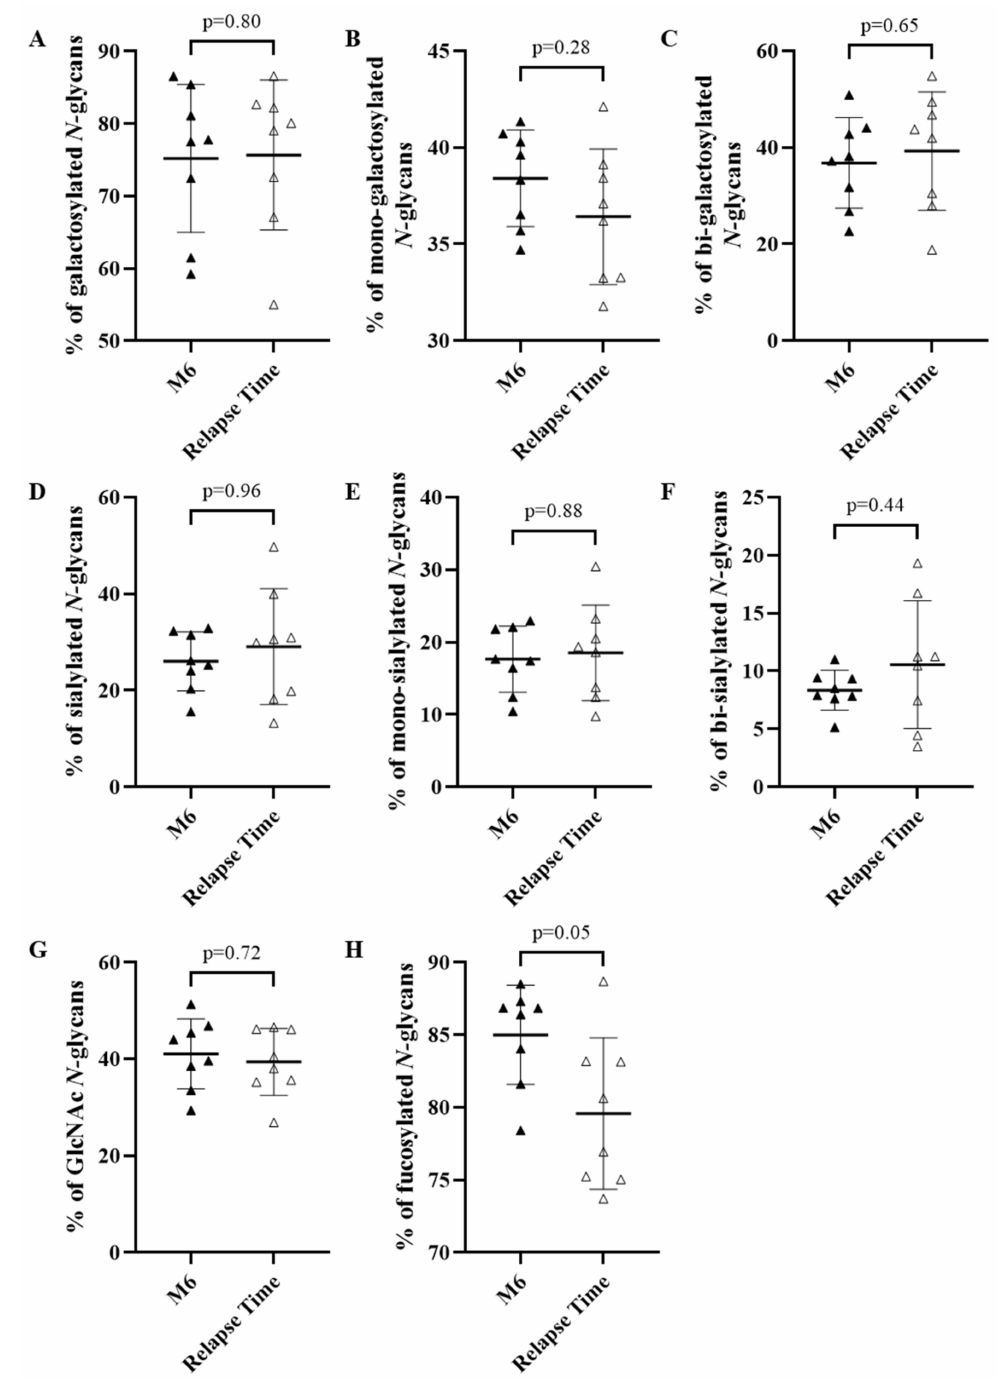
Figure 4. The N- glycome of relapsing patients during relapse occurrence compared to the N- glycome of non-relapsing patients at 6 months (M6). The percentage based on the relative quantification of galactosylated ( A ), mono-galactosylated ( B ), bi-galactosylated ( C ), sialylated ( D ), mono-sialylated ( E ), bi-sialylated ( F ), N- acetylglucosamine (GlcNAc) ( G ), fucosylated ( H ) subgroup of N- glycans from IgG of non-relapsing and relapsing patients for M6 and relapse occurrence, respectively. Means ± standard deviations were compared using a Mann–Whitney test. Differences were considered significant when p cor. < 0.006 with Bonferroni